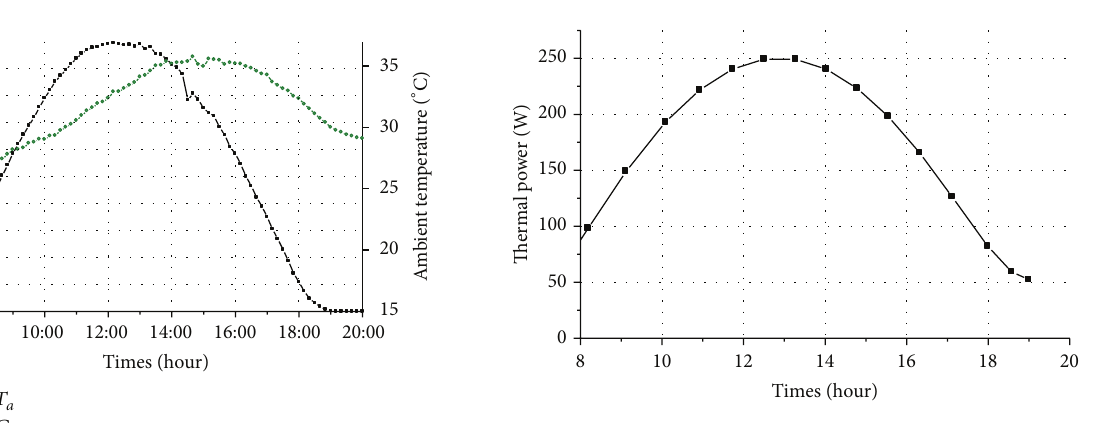
Figure 3: Thermal power produced daily by the hybrid